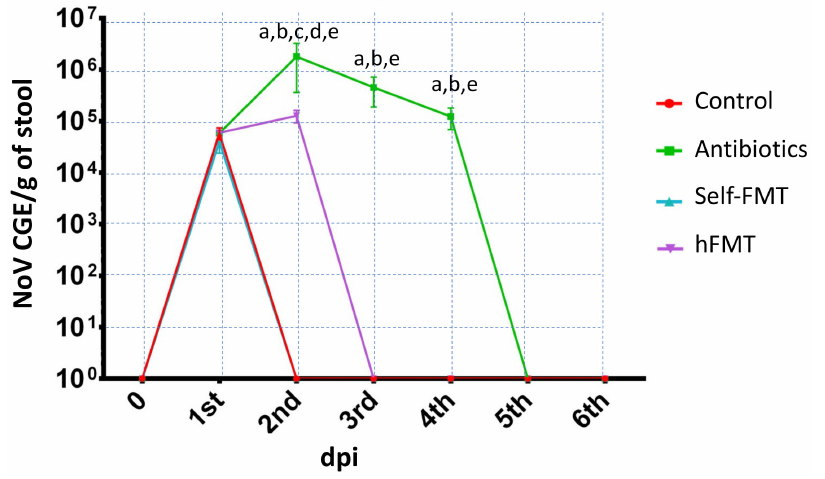
Figure 1. HuNoV GII.4 Sydney [P16] shedding in mouse stools . GCE/g of stool are shown for the control mice, Ab-treated mice and mice subject to hFMT and self-FMT, respectively. Mouse feces were sampled until dpi 6. The letters indicate statistically significant differences ( p < 0.05) in the GCE between the groups (a, Ab vs. control; b, Ab vs. self-FMT; c, hFMT vs. control; d, hFMT vs. self-FMT; e Ab vs. hFMT). The error bars are standard deviations (n = 5). The limit of detection was 10 4 GCE/g of stool. Ab, antibiotic; hFMT, human fecal microbiota transplantation; self-FMT, self-fecal microbiota transplantation; dpi, days post